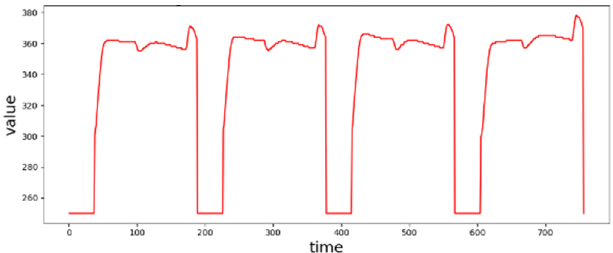
Figure 3. Ambiguity between normal and abnormal sequences of an SVID.